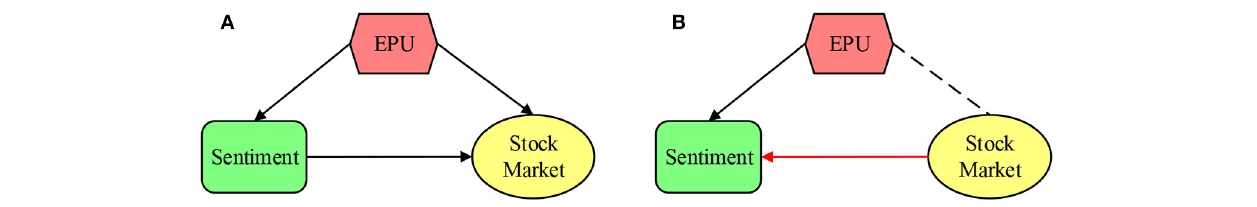
FIGURE 9 | The correlation among CN EPU, investor sentiment and the stock market. (A) The efficient market hypothesis. The stock market may be able to effectively reflect information regarding conventional investment and policy shocks. (B) China’s stock market is an inefficient market, and stock market volatility is an important factor affecting emotional